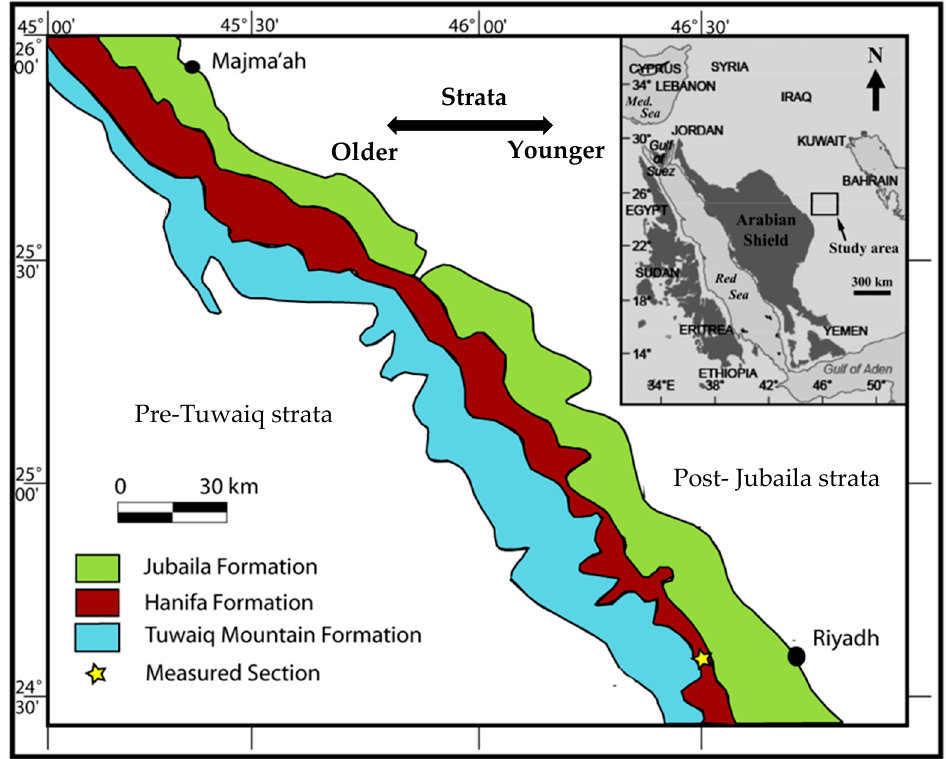
Figure 1. Geological sketch map showing the outcrop belts of Tuwaiq Mountain, Hanifa, and Jubaila formations in Central Saudi Arabia. The measured section is highlighted by the yellow star to the west of Riyadh modified after [34].